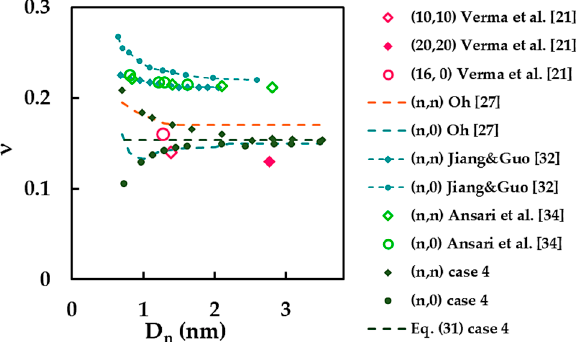
Figure 15. A comparison of the current Poisson ´ s ratio results with those from the literature as a function of the nanotube diameter, D n .